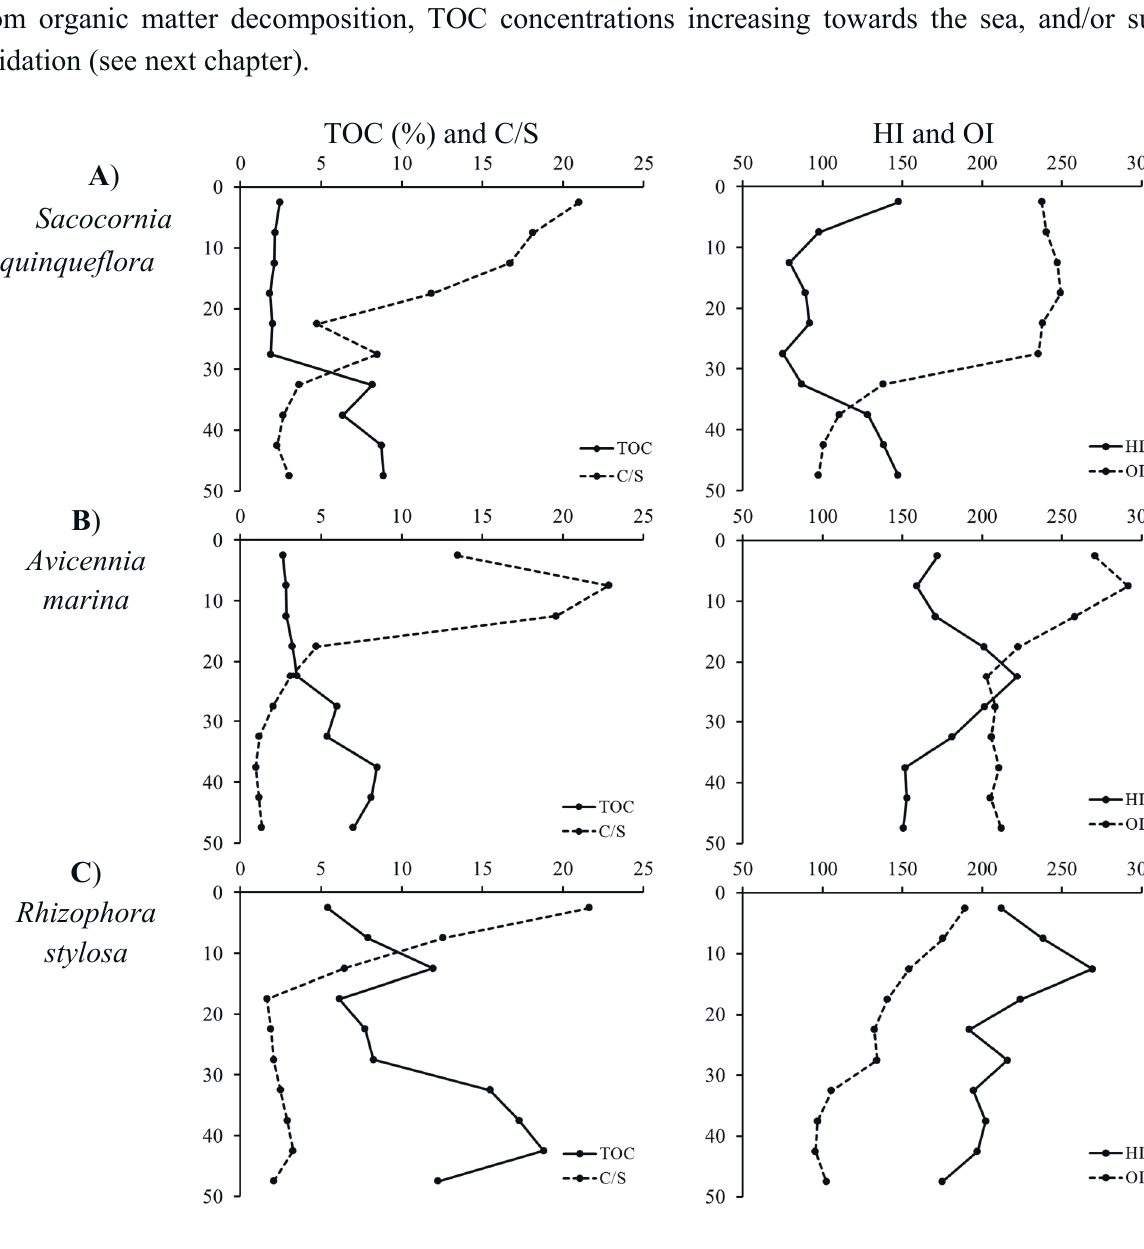
Figure 4. Total Organic Carbon (TOC%), Hydrogen Index (HI), C/S Ratios and Oxygen Index (OI) values in sediments of the three vegetation